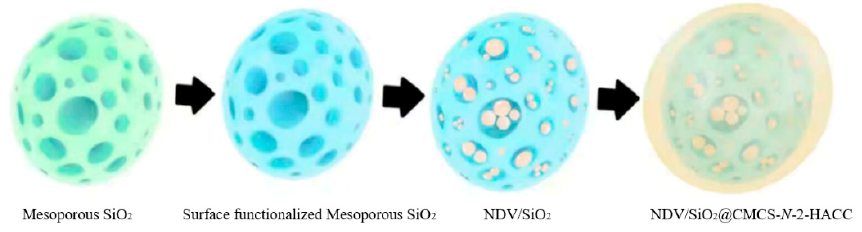
Figure 1. 3D model diagram from mesoporous SiO 2 nanoparticles to NDV/SiO 2 @CMCS- N -2-